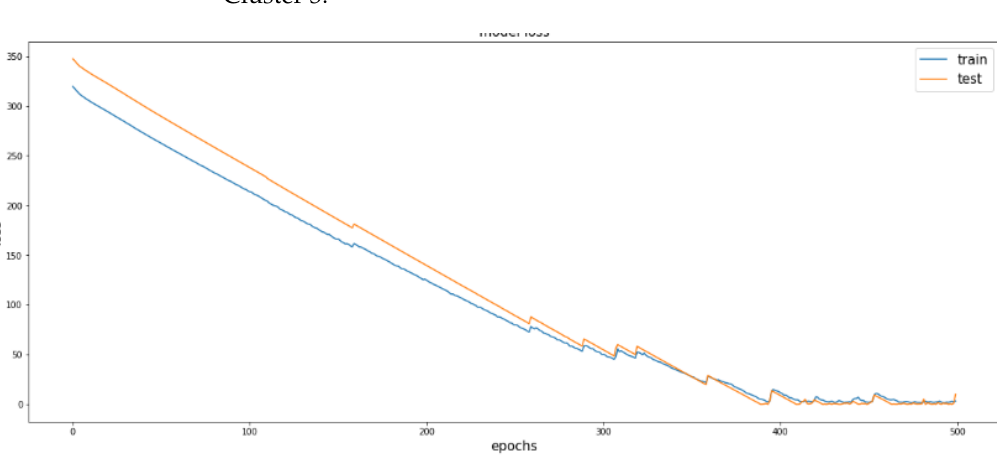
Figure 17. LSTM method for cluster 3 continuous-RULA . Mean squared error = 99.01424394693683.